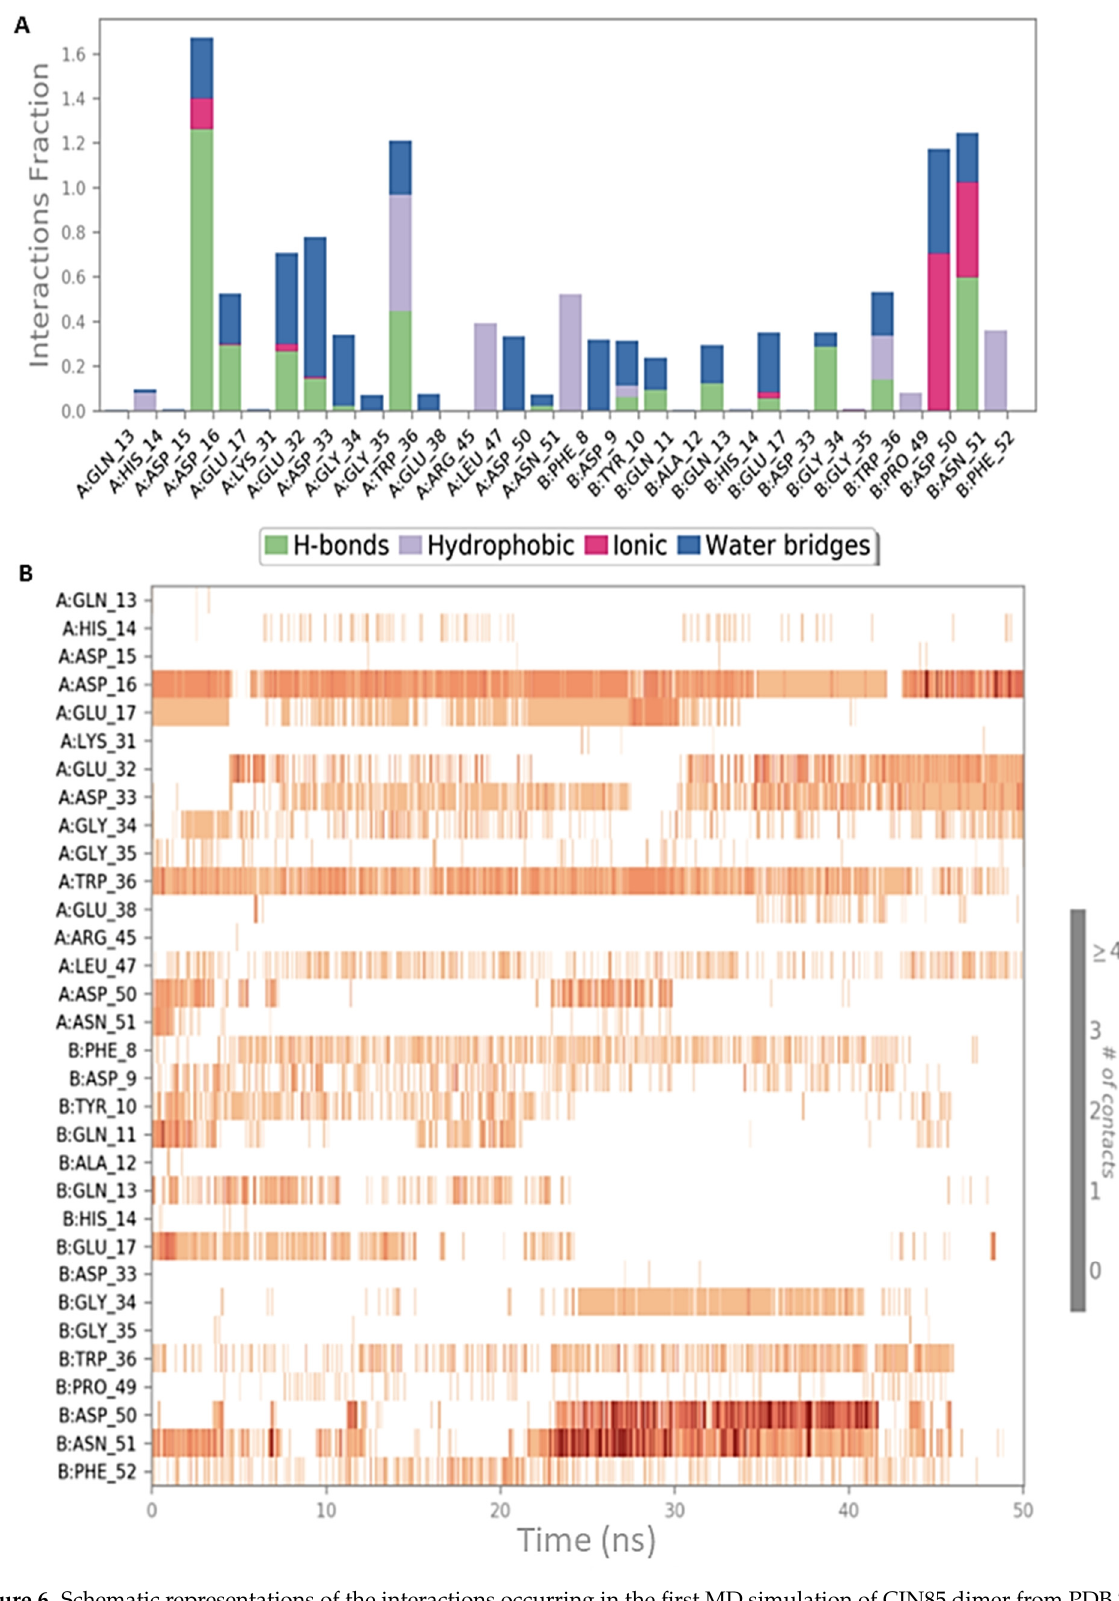
Figure 6. Schematic representations of the interactions occurring in the first MD simulation of CIN85 dimer from PDB 2BZ8 in complex with MUC1 peptide from PDB 5OWP. ( A ) Histogram plot highlighting the CIN85 residues involving in the interactions with MUC1. ( B ) Timeline representations of the interactions during the MD simulation.